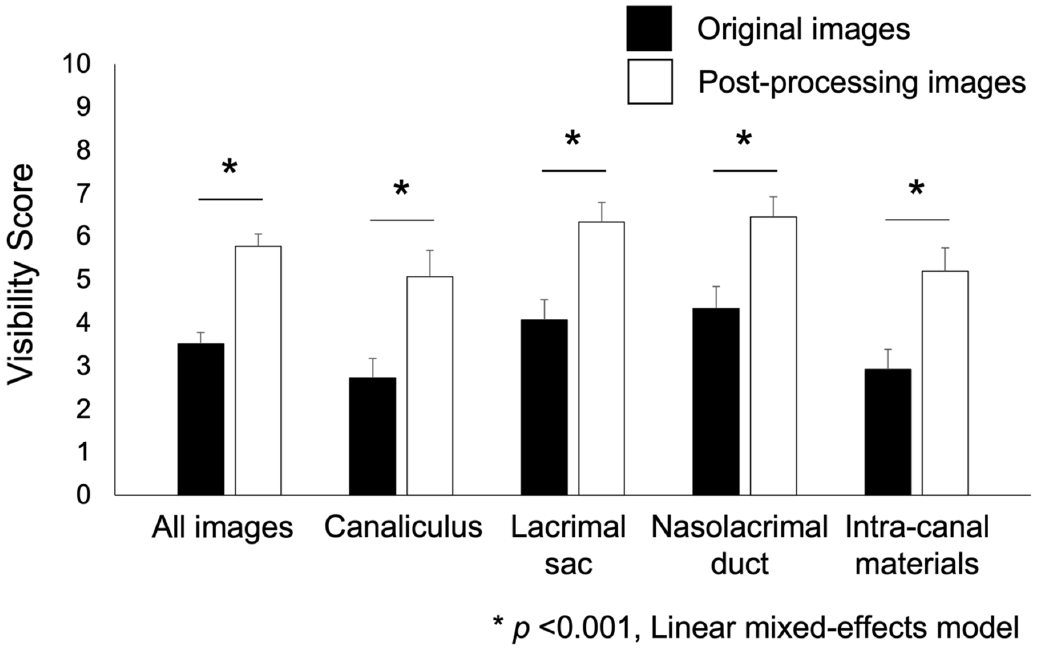
Figure 2. A graph comparing the visual scores of all images before and after image processing, in- cluding those of the canaliculus, lacrimal sacs, nasolacrimal ducts, and intra-canal materials.